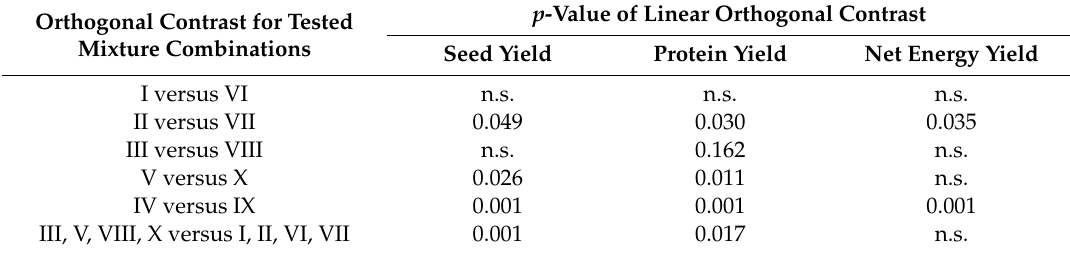
Table 9. Orthogonal contrast of selected treatments with covered barley depending on rate density Haplic